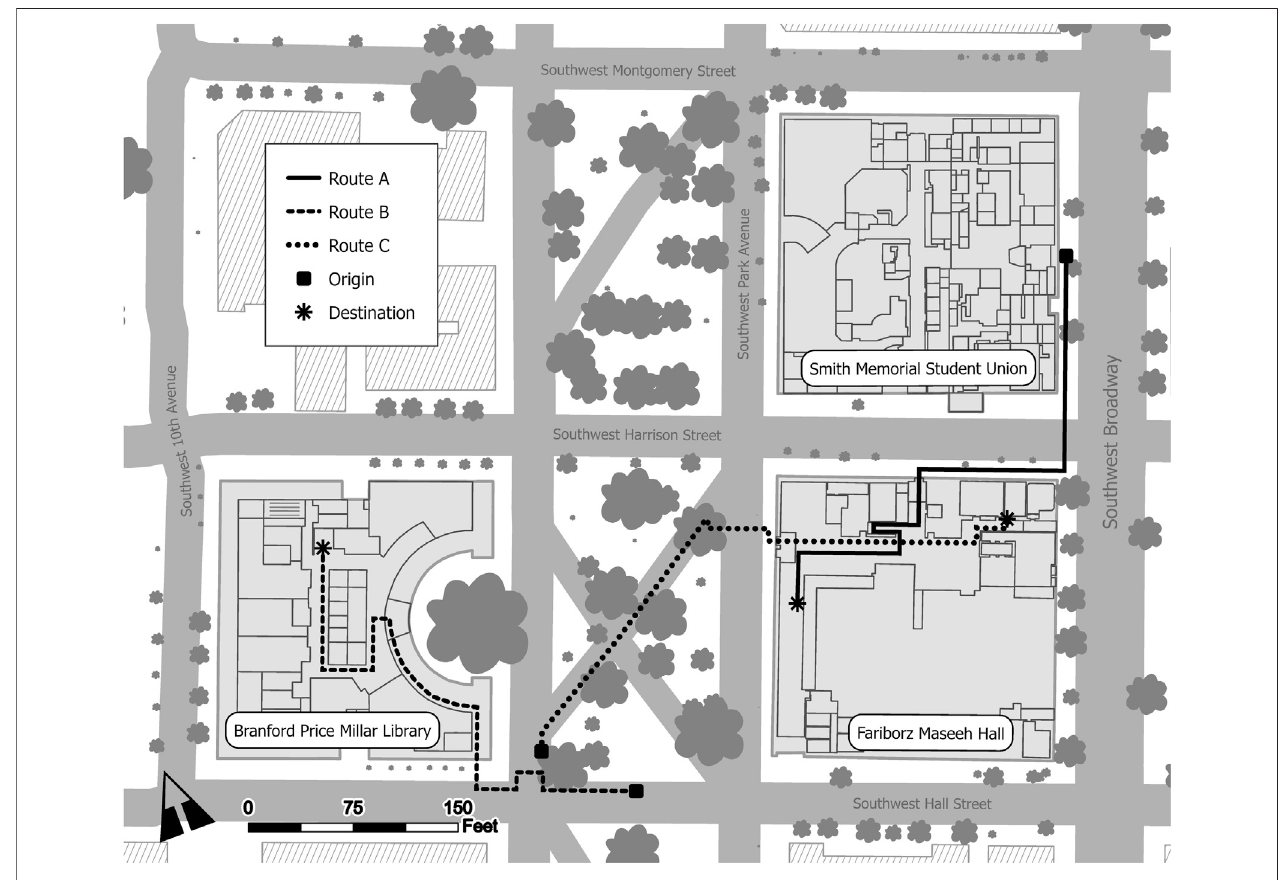
FIGURE 2 | Map of the three indoor/outdoor routes that we devised for our way fi nding study.